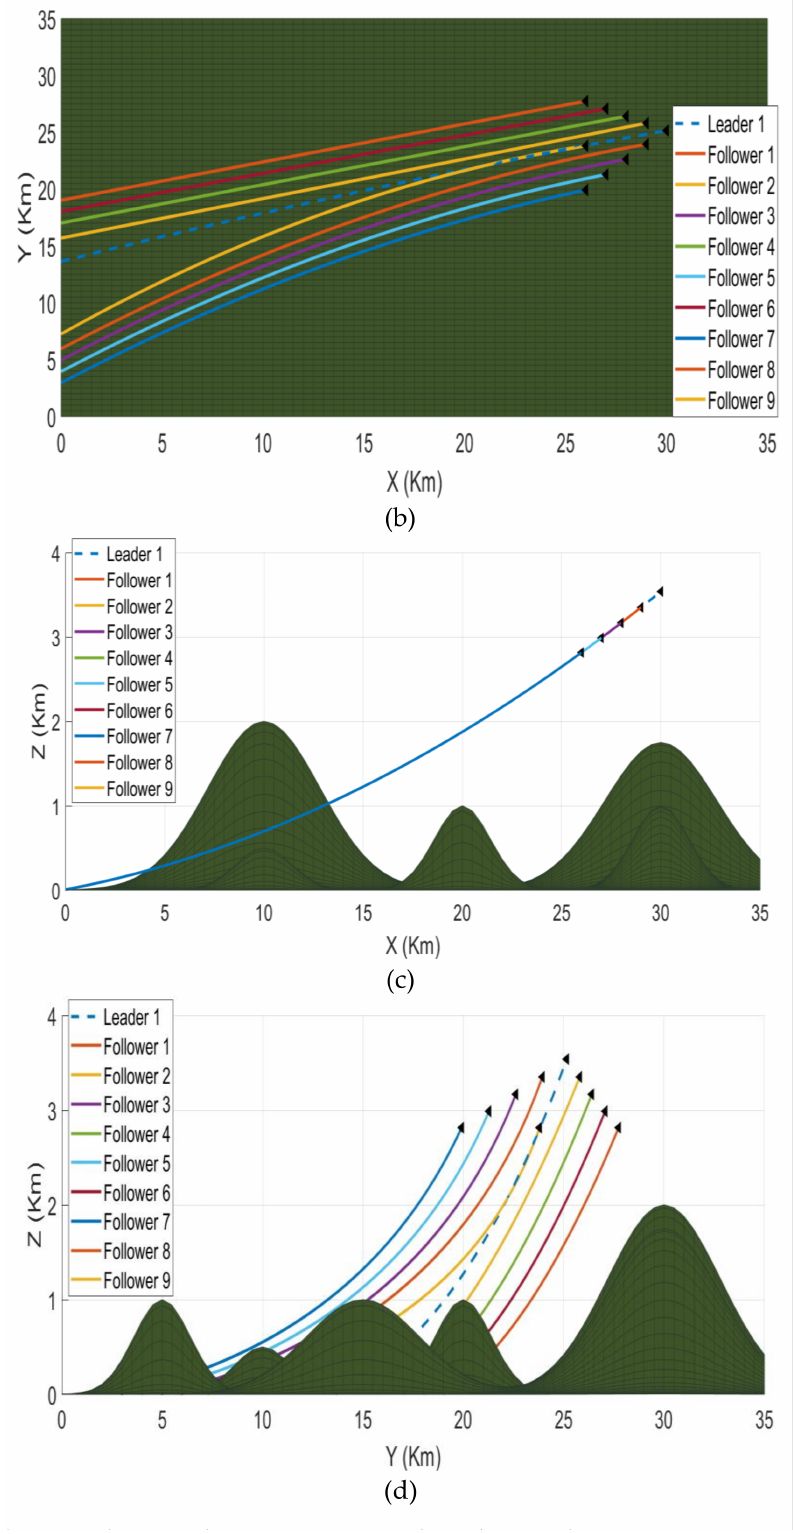
Figure 9. The second mission scenario where the two clusters merge into one big swarm; ( a ) shows the 3D version while ( b – d ) represent the XY , XZ , and YZ axis versions, respectively. The legend is the same for all